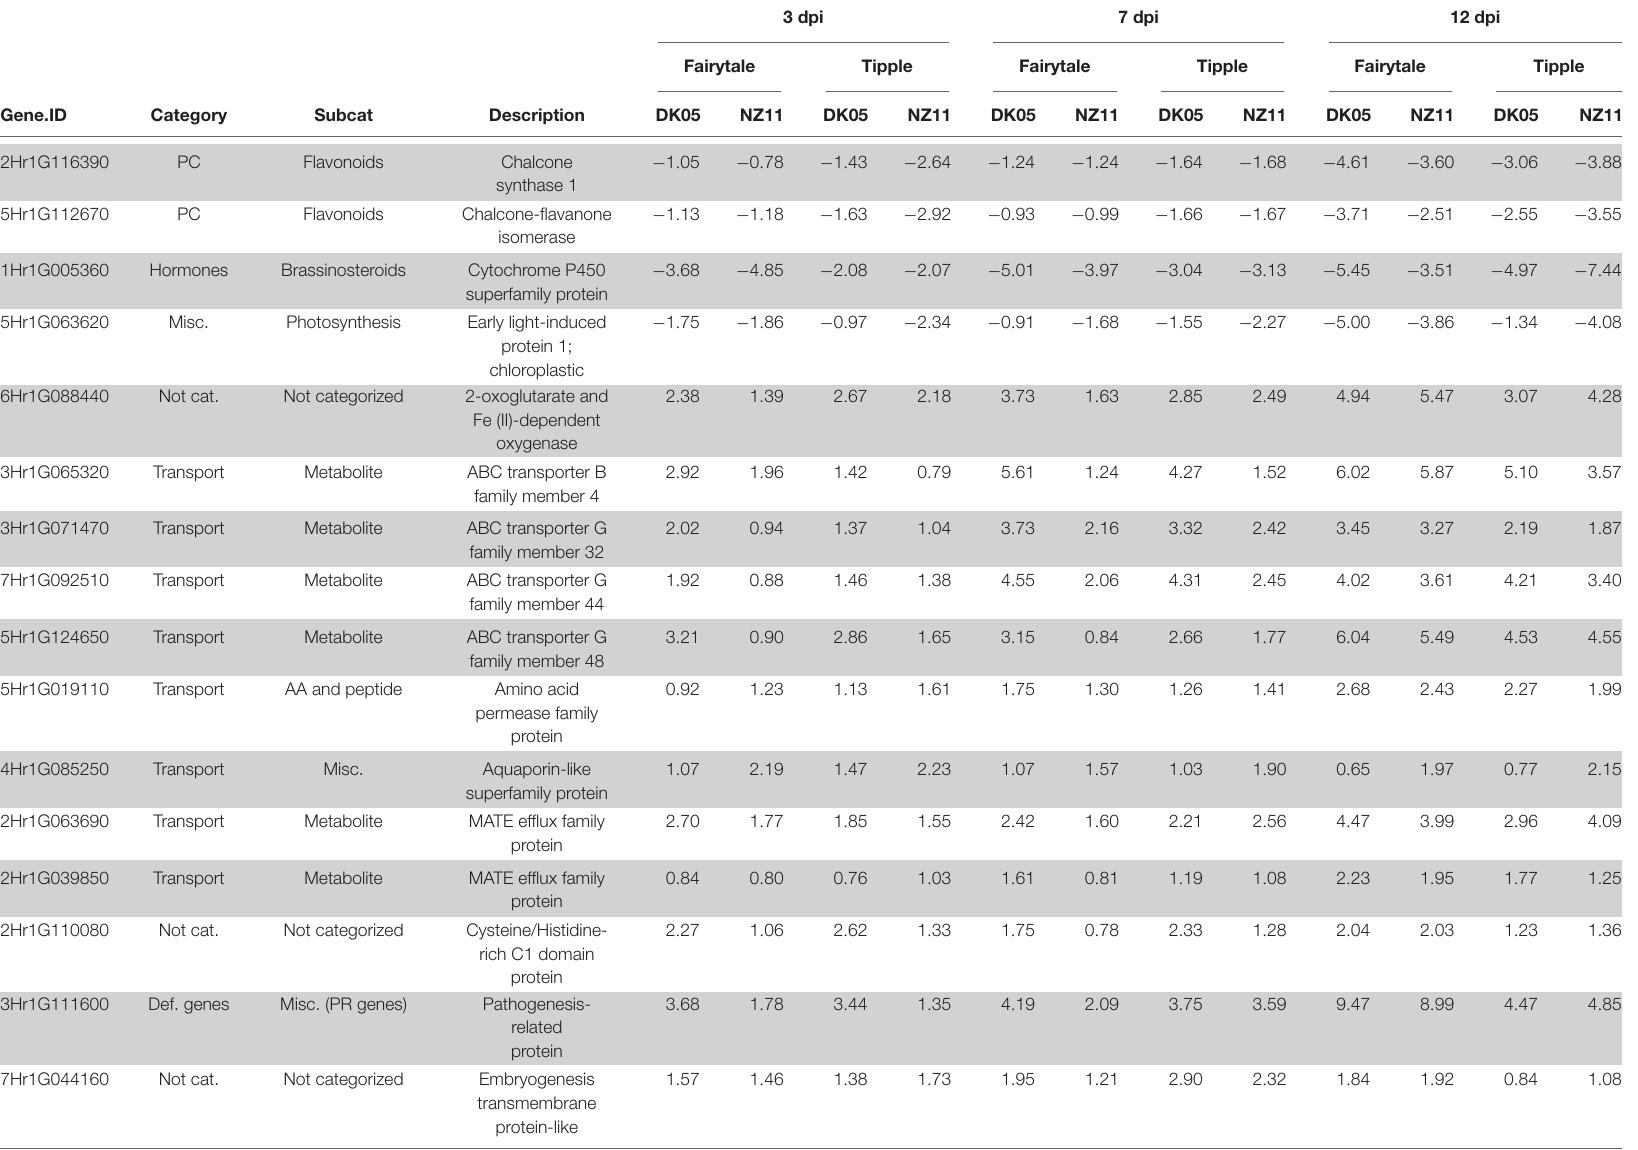
TABLE 2 | Differentially expressed barley genes regulated at all treatments and all time point during Ramularia collo-cygni